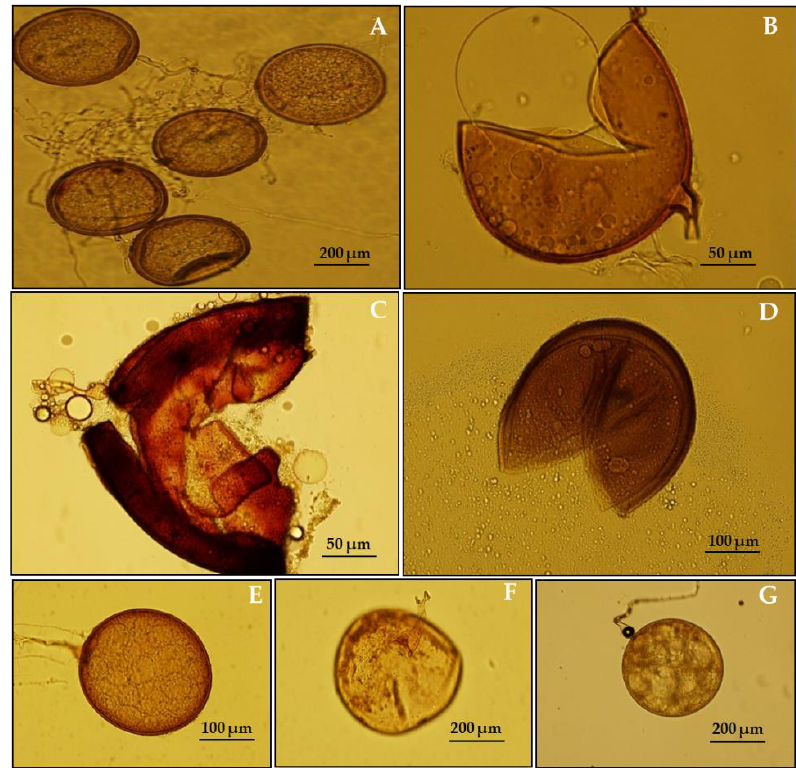
Figure 1. Showing arbuscular mycorrhizal fungi spores collected from the trap culture of Sabkha and non-Sabkha soil. ( A – D ) Sabkha Spores; ( E – G ) non-Sabkha spores. ( A ) intact spores of Claroideoglomus etunicatum; ( B ) crushed spore of Funneliformis mosseae ; ( C ) crushed spore of Gigaspora margarita ; ( D ) crushed spore of Scutellospora calospora ; ( E ) intact spore of Claroideoglomus etunicatum ; ( F ) intact spore of Funneliformis mosseae ; ( G ) intact spore of Gigaspora margarita